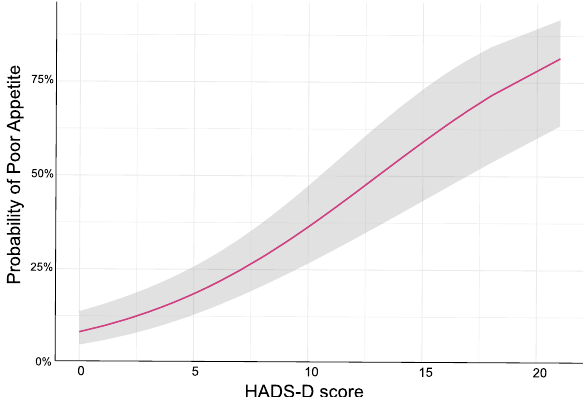
Figure 3. The relationship between severity of depression and risk of poor appetite after adjusting for age, HADS-D score, digestive disease, and malignancy as covariates, using a multilevel generalized linear model with binomial family and logit link. Grey areas show 95% confidence intervals. HADS-D is a subscale of the HADS that assesses depressive symptoms. A high HADS-D score indicates a high number of symptoms. Poor appetite was defined as a SNAQ score < 14. HADS, Hospital Anxiety and Depression Scale; HADS-D, Hospital Anxiety and Depression Scale—Depression